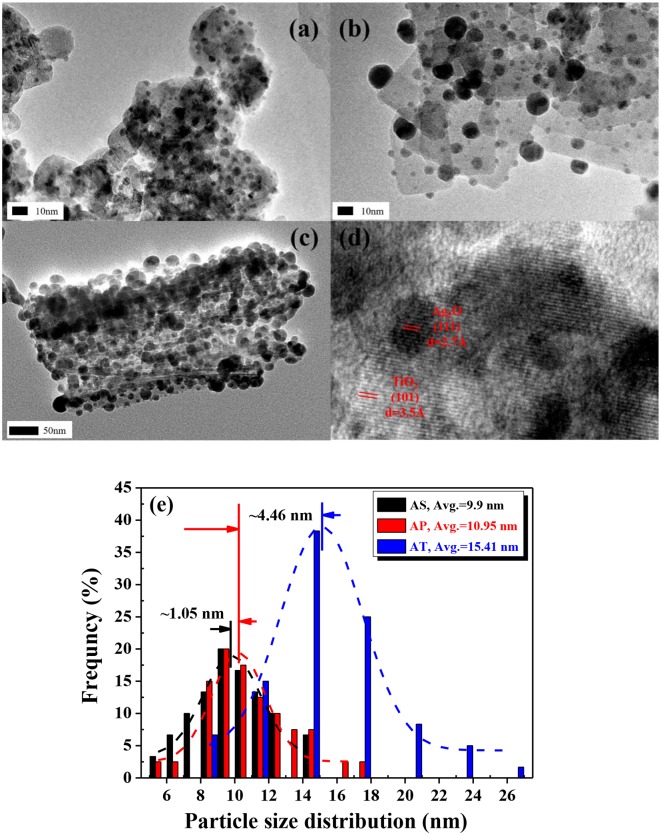
High-resolution transmission electron microscopy (HRTEM) images of: (a) Ag2O-TiO2 nanosphere (AS), (b) Ag2O-TiO2 nanoplate (AP), (c) Ag2O-TiO2 nanotube (AT), (d) the lattice of TiO2 and Ag2O, and (e) particle size distributions of Ag2O on AS, AP, and AT, respectively.